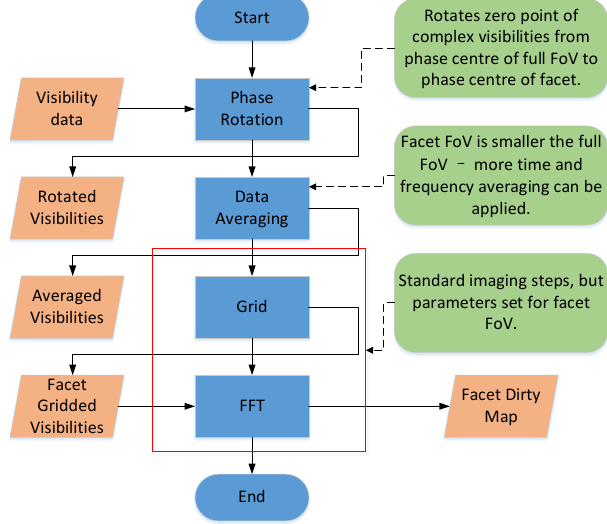
Figure 2. The procedure of Facet Imaging on one facet.